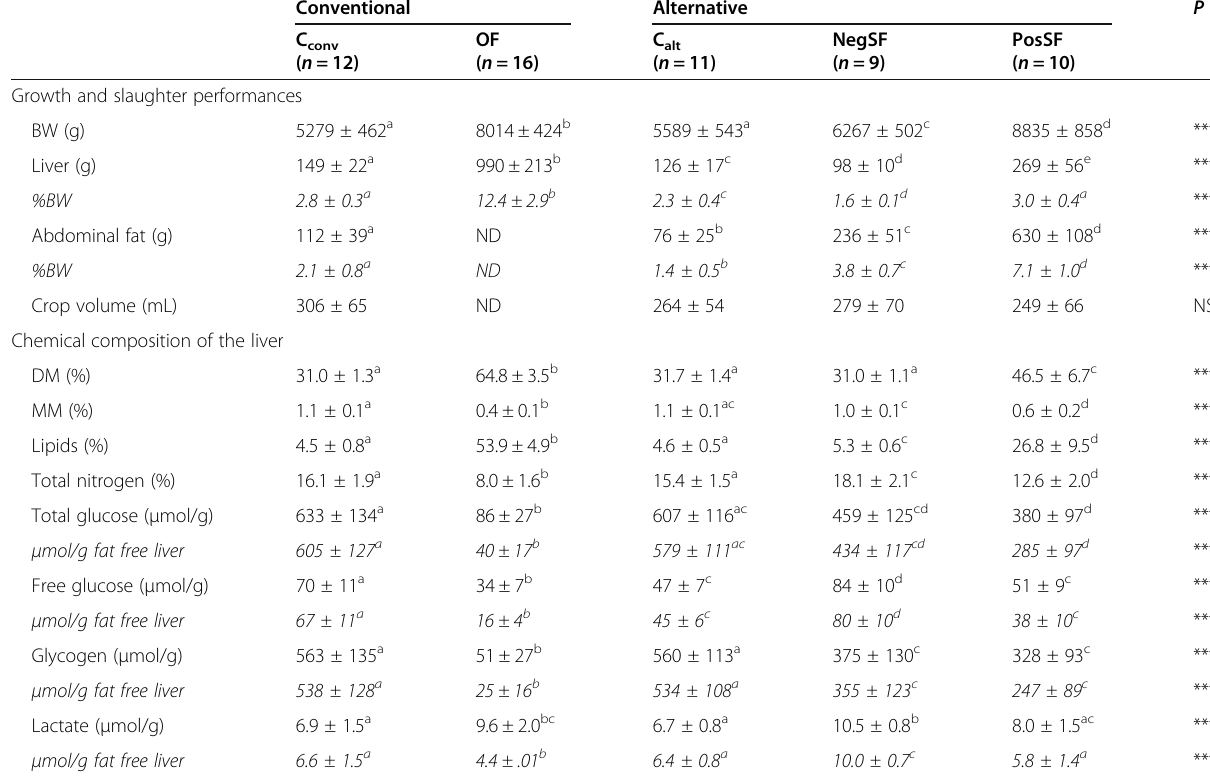
Table 1 Growth and slaughter performances and chemical composition of the livers according to the experimental group Conventional